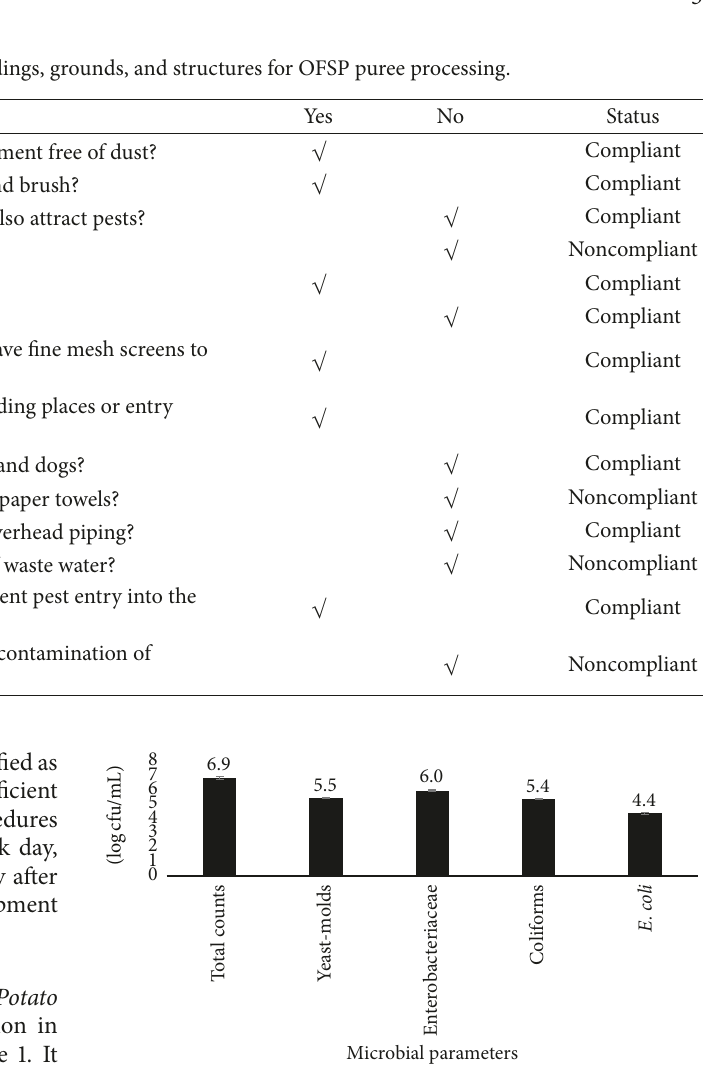
Figure 1: Microbial load in water for processing Orange Fleshed Sweet Potato puree; the values above the bars represent the mean ± SEM (standard error of the